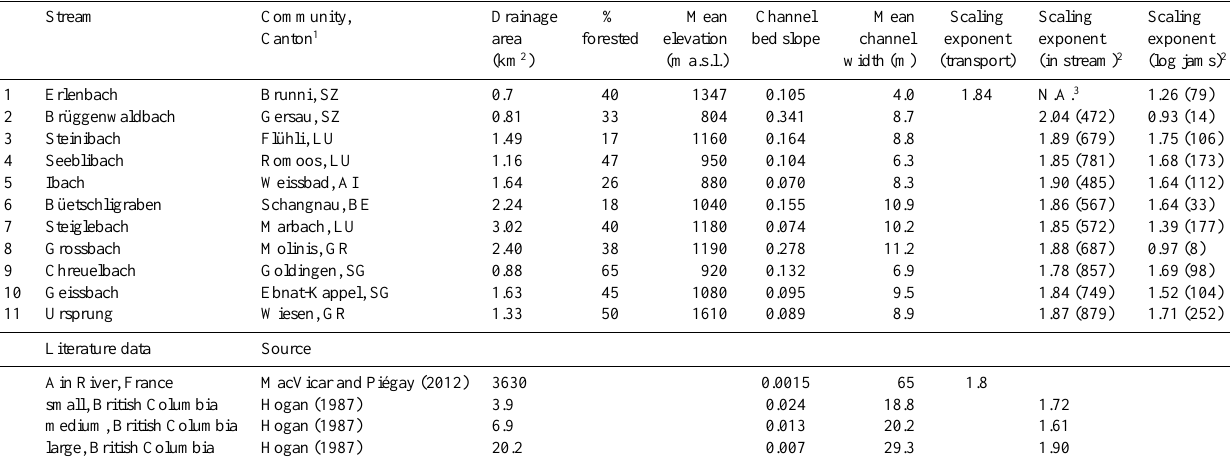
Table 1. Characteristics of the Swiss streams and scaling exponents (see also Fig. 1). Stream Community, Drainage % Mean Channel Mean Scaling Scaling Scaling Canton 1 forested elevation bed slope exponent